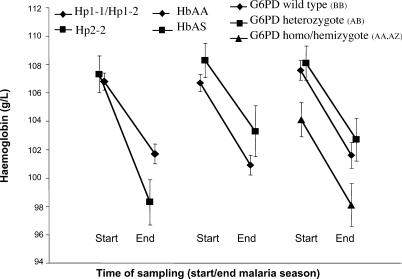
Drop in Haemoglobin Level during the Malaria Season according to HbAS, G6PD Deficiency, and Haptoglobin GenotypeHaemoglobin levels at the start and end of the malaria season are shown by haptoglobin genotype (
Hp
2/2 versus
Hp
1/1 and
Hp
1/2 combined), HbAS compared to HbAA and G6PD (A type) deficiency, wild-type, heterozygotes, and homozygotes/hemizygotes. Error bars denote standard error of the mean.